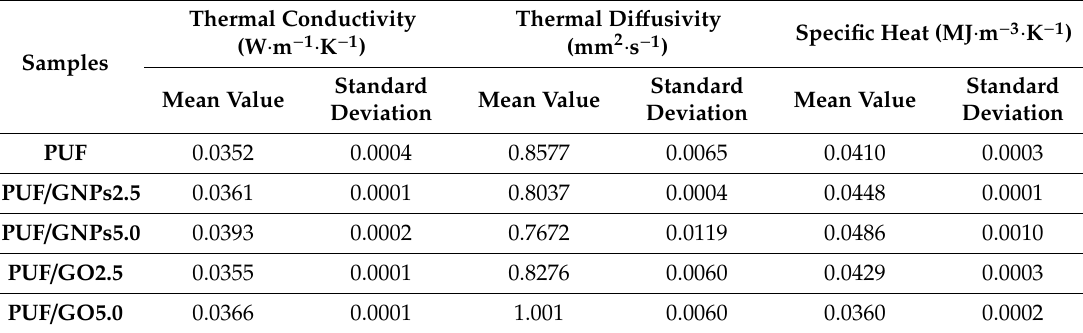
Table 3. Thermal conductivity, thermal di ff usivity, and specific heat (n = 5).